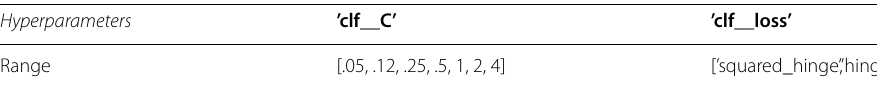
Table 10 Hyperparameters optimized for SVM